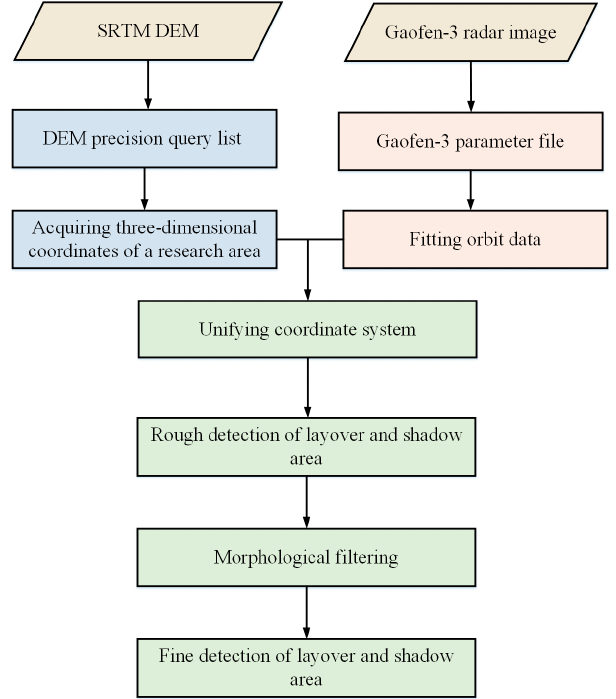
Figure 6. The fl owchart of layover and shadow area detection. Figure 6. The flowchart of layover and shadow area detection. Table 2. Parameters for track